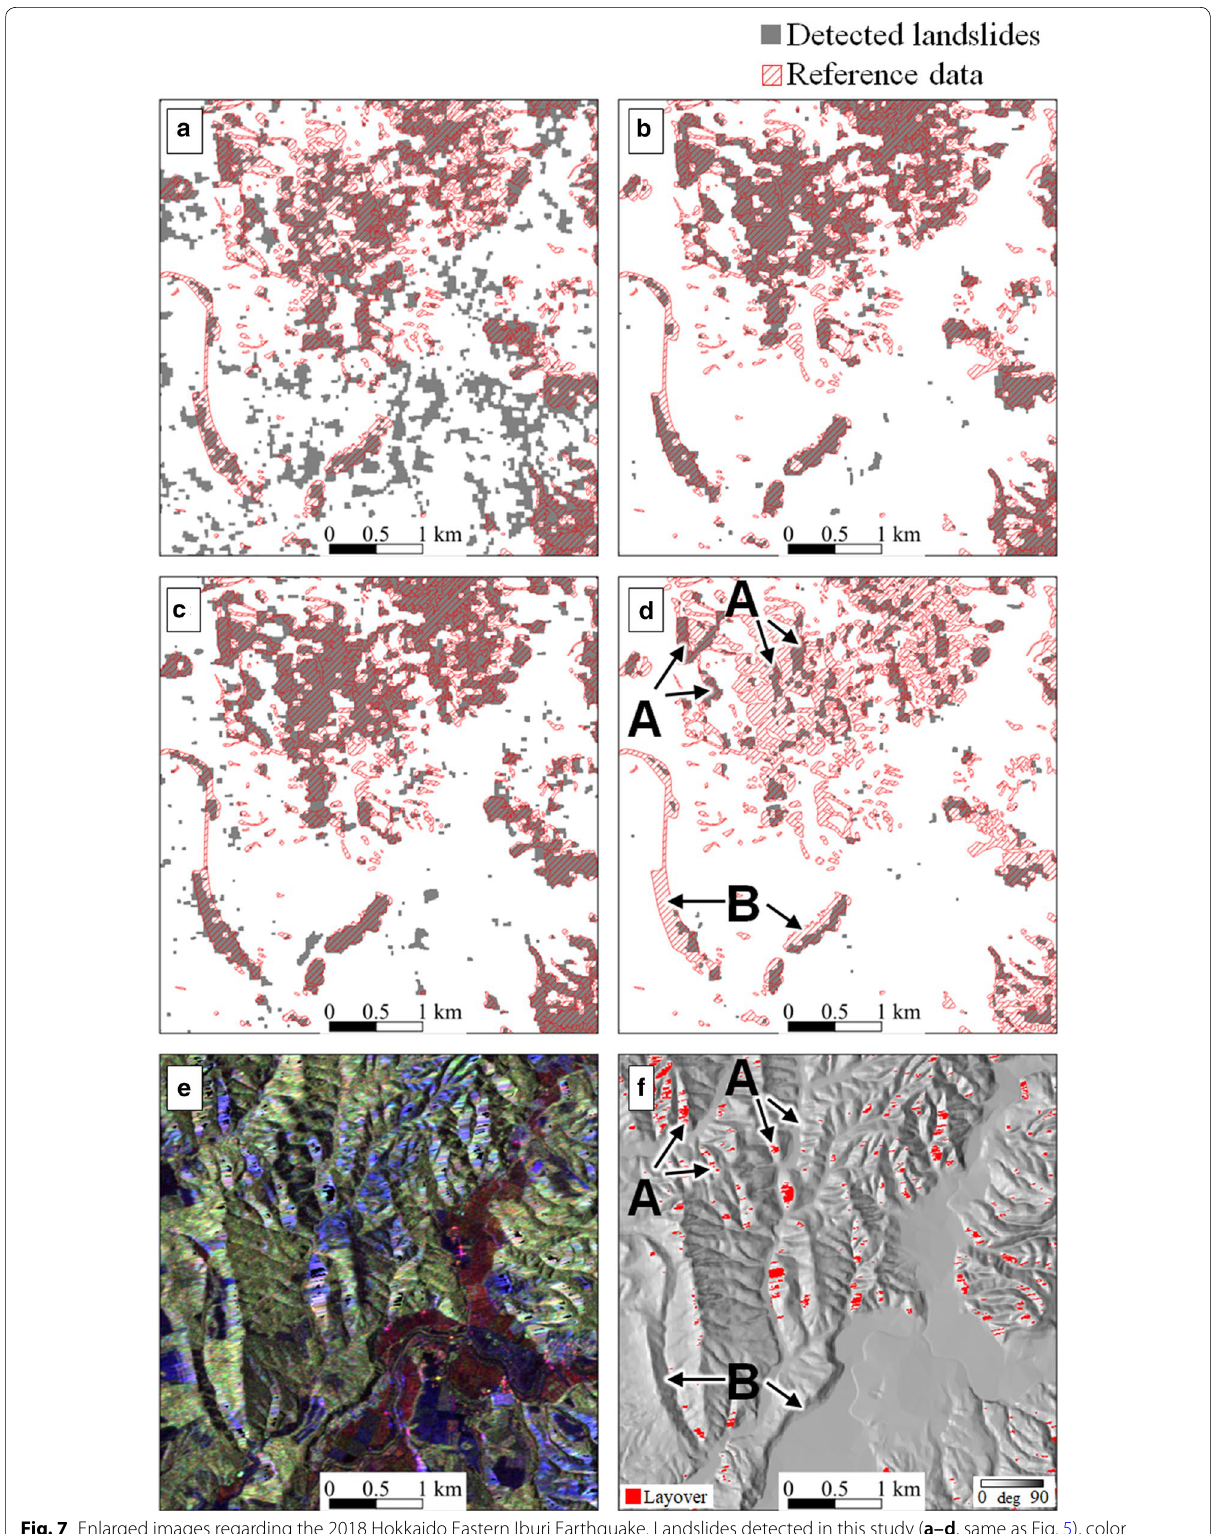
Fig. 7 Enlarged images regarding the 2018 Hokkaido Eastern Iburi Earthquake. Landslides detected in this study ( a–d , same as Fig. 5), color composite of Pauli components ( e ), and local incidence angle overlaid with the layover areas ( f